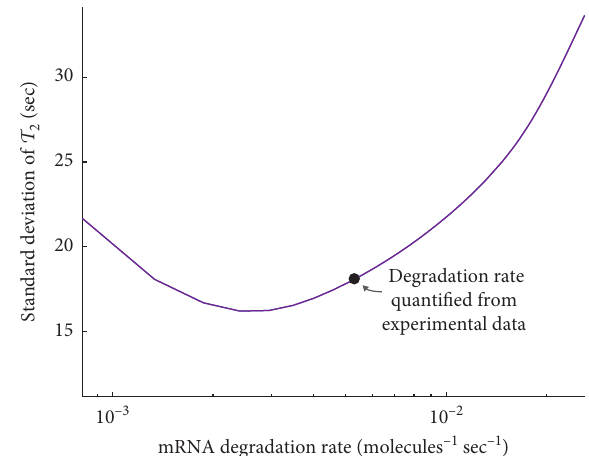
Figure 8: Optimal mRNA degradation rates to reduce uncertainty about the extracellular environment. Uncertainty in the time at which the STL 1 gene turns off, τ , as a function of mRNA deg- 2 radation rate (purple). The black dot corresponds to the degra- dation rate that was quantified from experimental